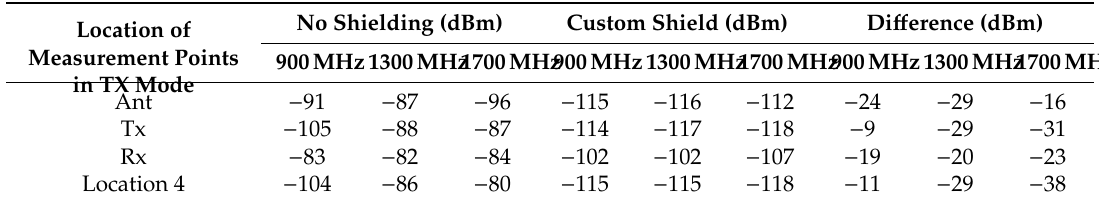
Table 4. Average receive B210 board (Rx) mode leakage signal measurements at designated locations for 900, 1300, and 1700 MHz, respectively.